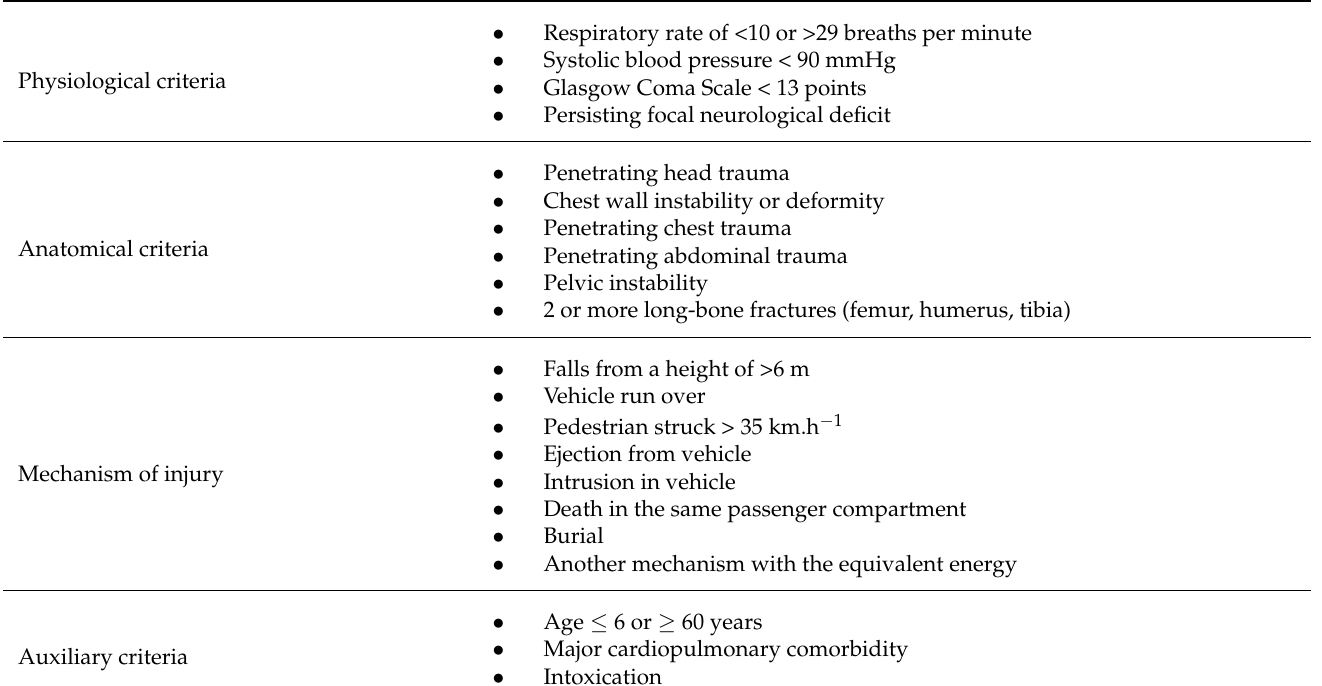
Table 1. The national criteria for on-scene trauma